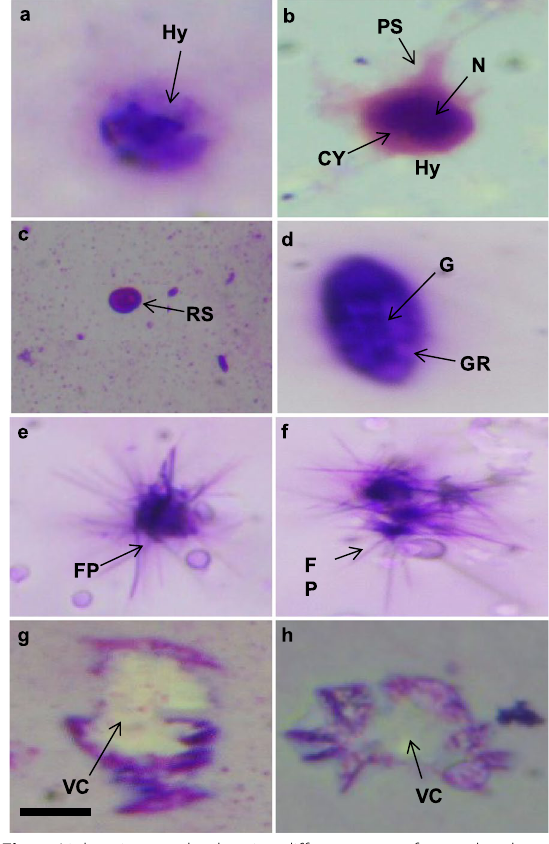
Fig. 4 Light micrographs showing different types of normal and abnormal hemocytes of Biomphalaria alexandrina after exposure to RIPEX 48% EC. a – d : normal hemocytes; a , b : Hyalinocyte, c Round small cell. e , f spreading hemocytes after exposure to 8 µL/L of ethephon. g , h Vacuolated hemocytes after exposure 16 µL/L of ethephon. (Hy) Hyalinocyte; (RS) Round small; (GR) Granulocyte (SP) Spreading cell and (VC) Vacuolated cells. PS: Pseudopodia, N: Nucleus, CY: Cytoplasm, G: Granules, FP: Filopodia. Scale bar 20 =